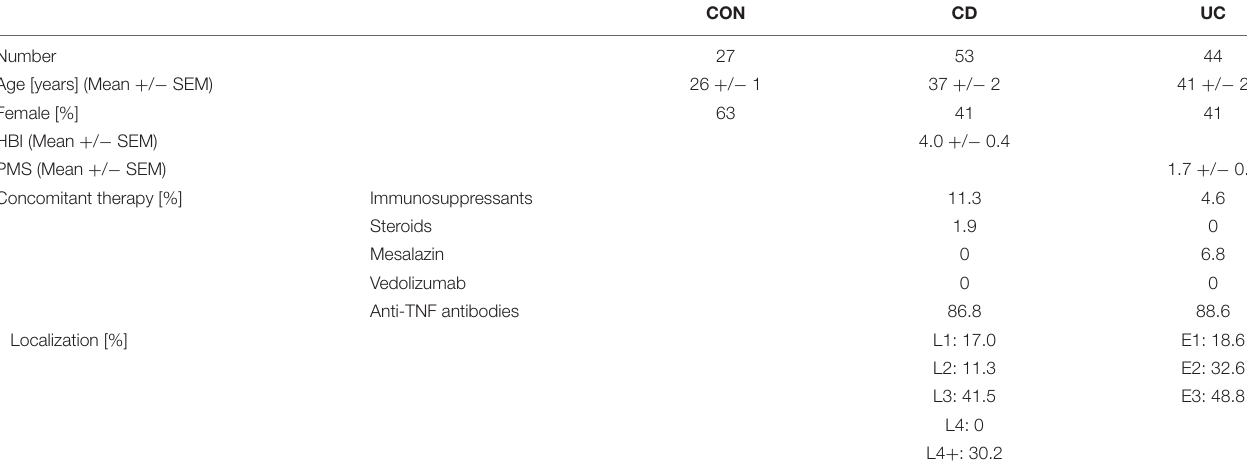
TABLE 1 | Patient